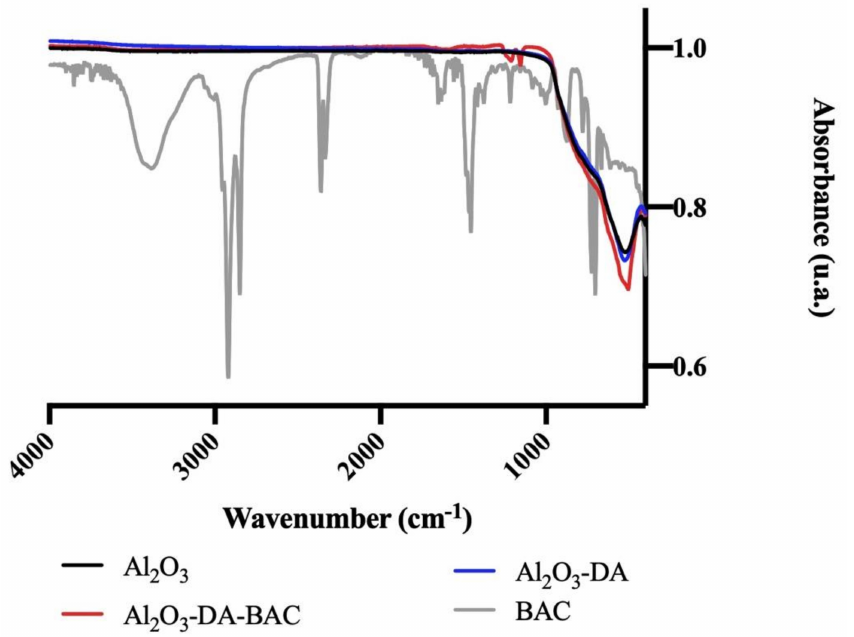
Figure 5. Fourier-Transform Infrared Spectroscopy (FTIR) spectra of functionalized and Al 2 O 3 particles. Benzalkonium chloride (BAC) in solution was used as control.